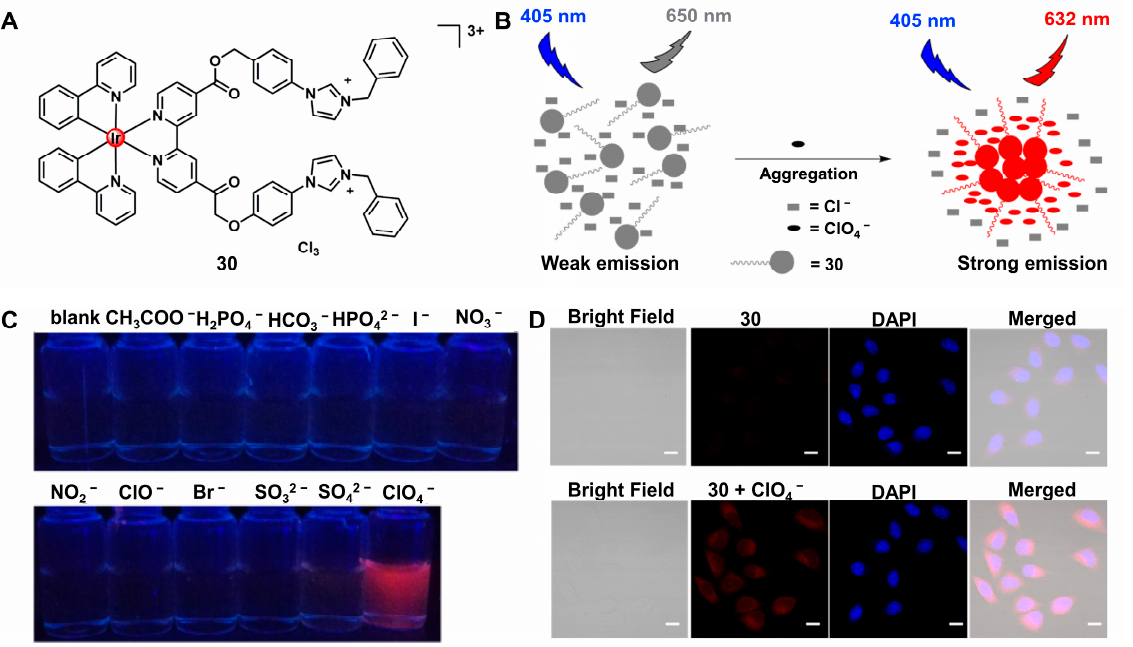
Figure 13. ( A ) The chemical structure of 30 . ( B ) Proposed possible processes of ClO 4 − with 30 in H 2 O. ( C ) Corresponding images of ClO 4 − and other anions under 365 nm UV illumination. ( D ) CLSM photographs of HeLa cells. Reprinted with permission from [77], copyright 2017,